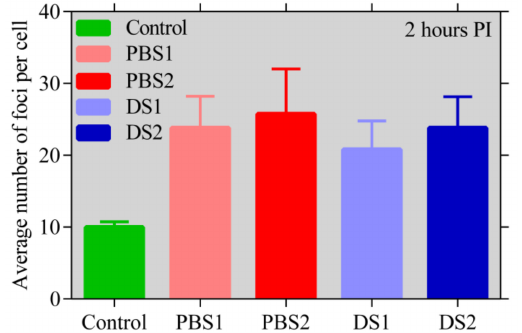
Figure 5. The average numbers of γ H2AX foci per nucleus with their standard deviations compared for the two modes and the two positions in the proton beam path; measured two hours post irradiation by dose 1 Gy. No statistically significant di ff erences have been found using the t